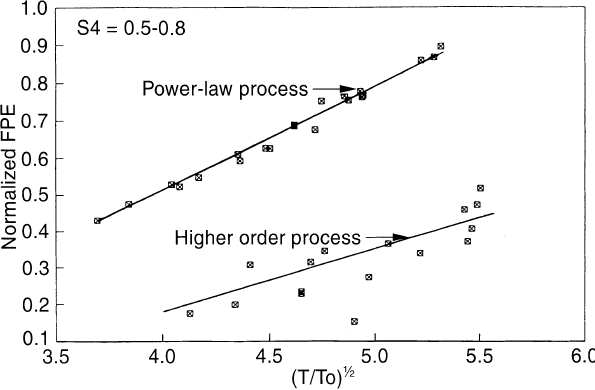
Fig. 10. This is a plot of the normalized final prediction error (obtained from AR algorithm based on Akaike criterion) versus the smoothing parameter ( T/T 0 ) 1/2 . The linear trend displayed by the power-law process indicates that the lower order processes are more amenable to smoothing than the higher order process due to the latter possessing in intrinsic